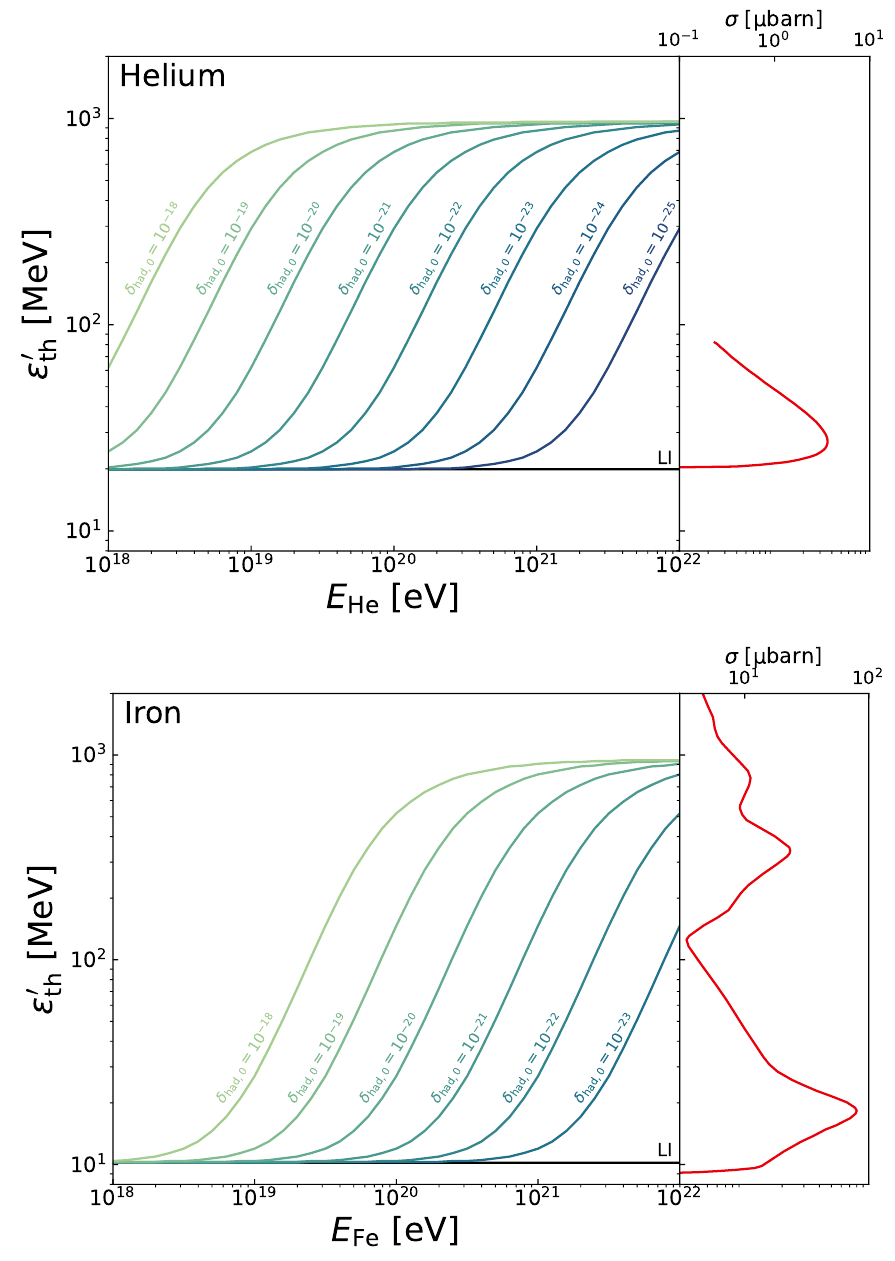
Figure 8. Energy threshold in the NRF for the photodisintegration. The black line shows the results for a LI assumption, while the different colored lines show the results for different LIV coefficients. The right panel shows the cross section for that given energy, based on the parameterizations from [69]. Top and bottom panels correspond to an initial nuclues of helium and iron,